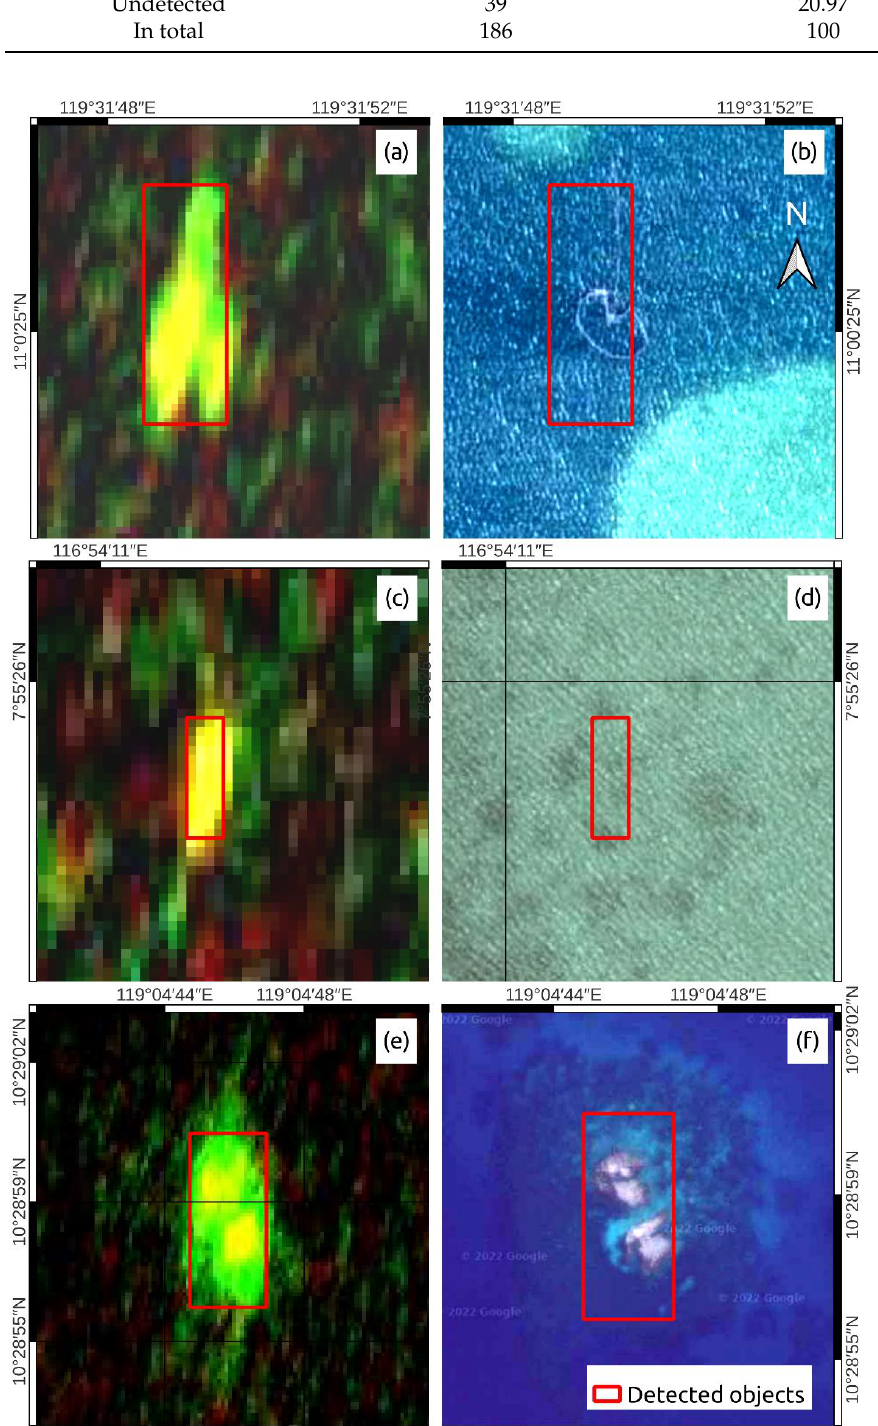
Figure 9. Examples of false alarms in SAR data (left column) and Google Earth images (right column): ( a , b ) fish corral; ( c , d ) coral reef; ( e , f ) rocks.